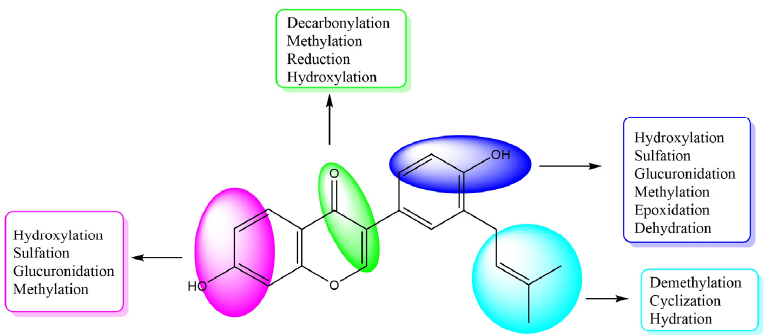
Molecules 2022 , 27 , x FOR PEER REVIEW Figure 5. The summarized metabolic features of neobavaisoflavone in rats. Figure 5. The summarized metabolic features of neobavaisoflavone in rats.